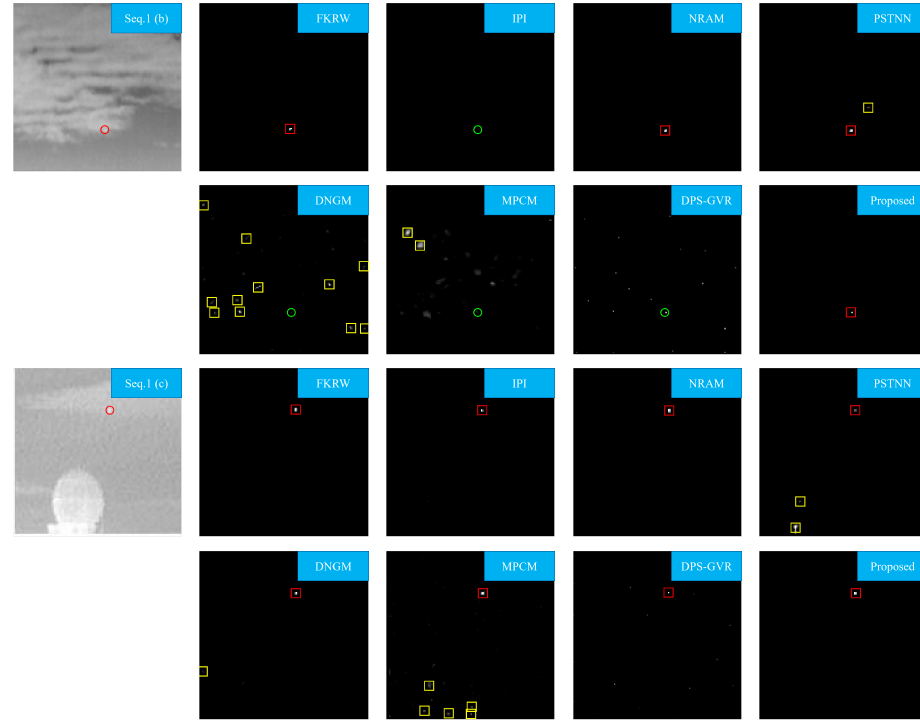
Figure 8. Original images and the corresponding enhanced images by the different methods for Seq.1. The red circles indicate the position of the actual targets. The green circles mark missing detections. The correct and false segmentation results are marked by red and yellow boxes, respectively.